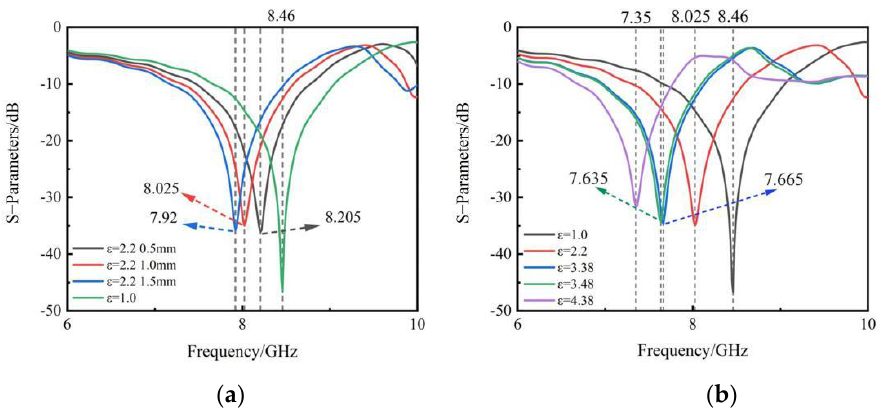
Figure 3. ( a ) Simulated S21 amplitude curves of different thicknesses where the ε of the standard MUT is 2.2; ( b ) Simulation results for different permittivities with an MUT thickness of 1 mm.